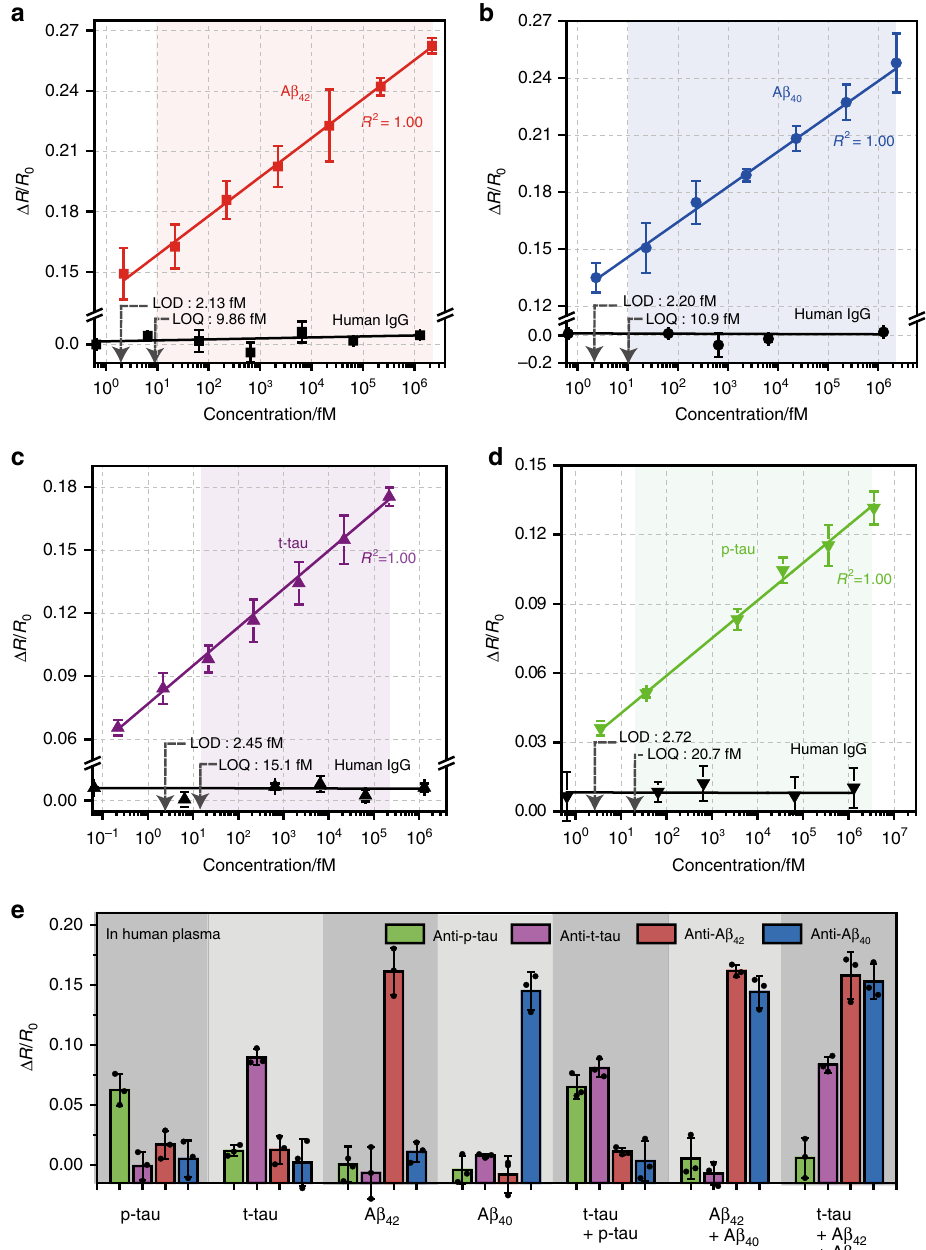
Fig. 3 Densely aligned CNT sensor arrays ’ sensitivities toward AD core biomarkers. Changes in resistance of the densely aligned CNT sensor array with the increasing concentration of ( a ) A β 42 , ( b ) A β 40 , ( c ) t-tau, and ( d ) p-tau. Each data point was attained using a different set of devices. The human IgG was used as a negative control. e Selectivity of the densely aligned CNT sensor array toward various individual AD biomarkers and their mixtures in human plasma. The concentrations of A β 42 and A β 40 were 22.2 and 23.1 fM, respectively. In the case of t-tau and p-tau, the concentrations were 21.8 fM and 360 fM, respectively. The measurement was performed in triplicate and all reported values represent the mean ± SD. Source data are provided as a Source Data fi